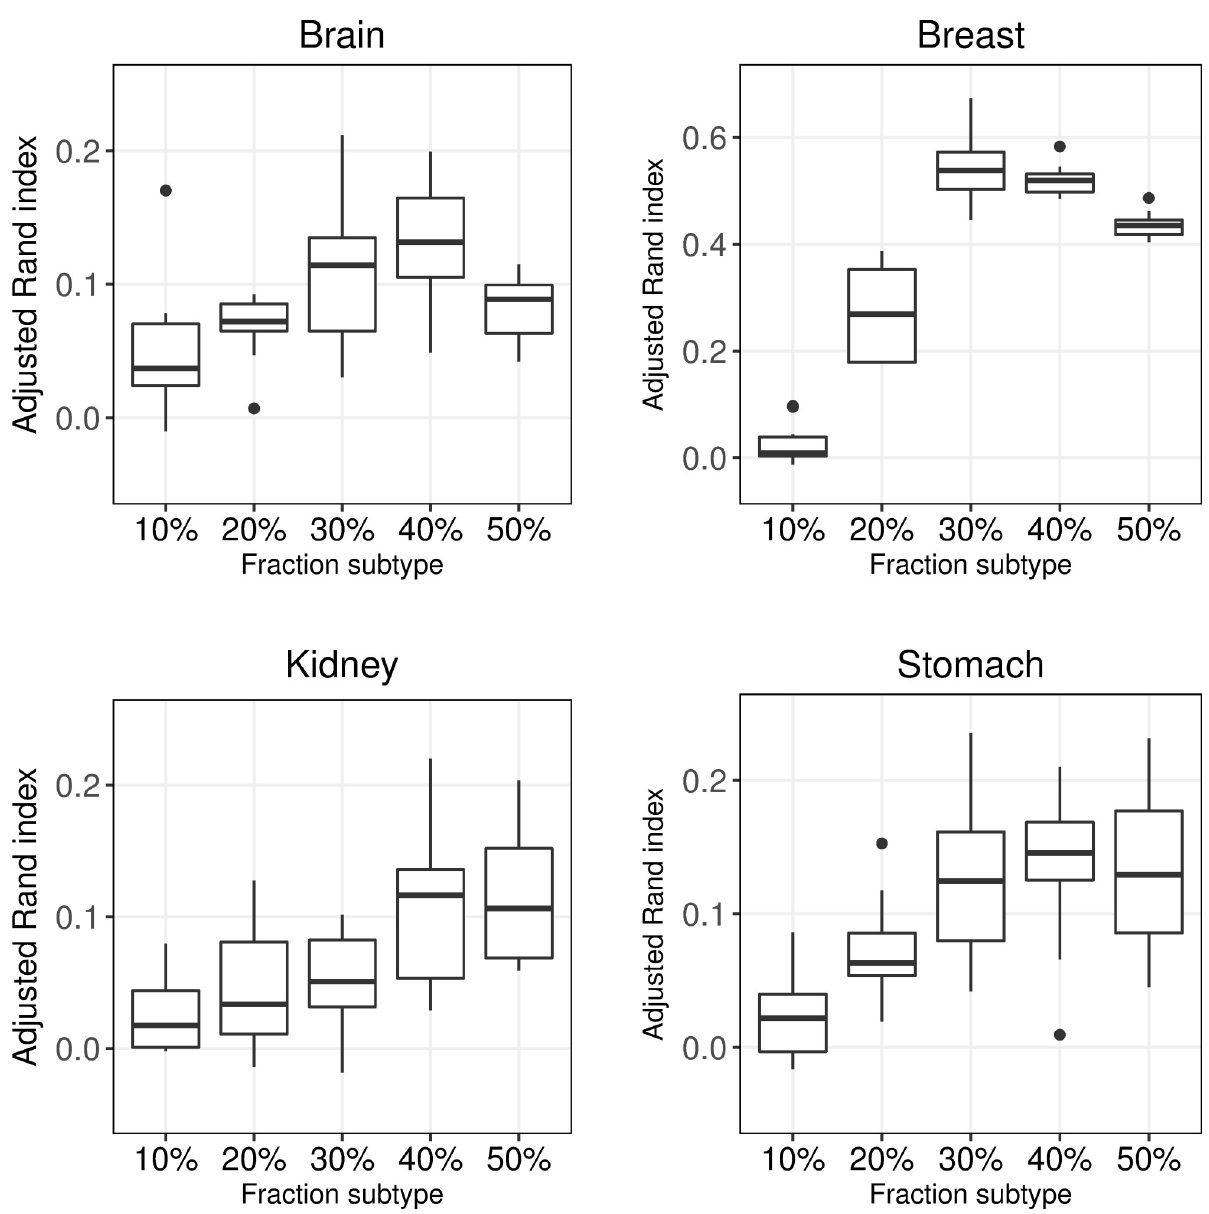
Fig 5. Distribution of subtypes. Adjusted Rand index for subtype fractions 10%– 50%. Each box contains mean adjusted Rand index values (taken over of all 30 clustering approaches) for 10